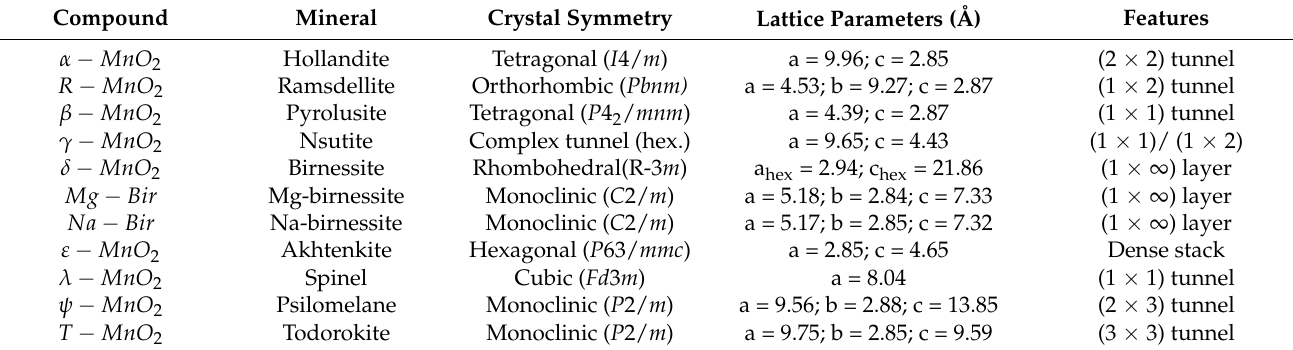
Table 1. Summary of crystallographic data of different manganese dioxide phases, summarized from Julien and Mauger [20]. Compound Mineral Crystal Symmetry Lattice Parameters (Å)